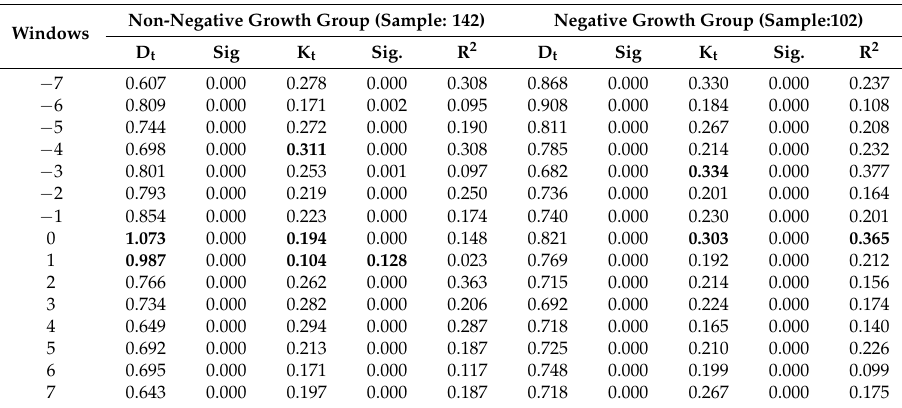
Table 6. Results of the model for announcement samples in 2014 in the Second-Board Stock Market: Positive Growth vs. Negative Growth on